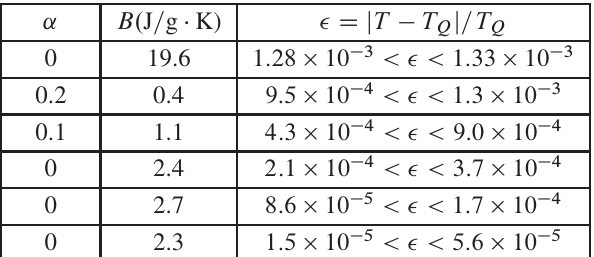
Table 3. Values of the critical exponent ˛ for the specific heat C p and the amplitude B within the temperature in- terval (cid:4) for the ˛ - ˇ phase transition ( T Q D 577:1 ı C) in quartz according to Eq. (1) where A D 1:2 J = g (cid:3) K. The experimental C p data [2] was analyzedabove T Q along heating curve. The renormalized ˛ R values (Eq. 3) are also given here.